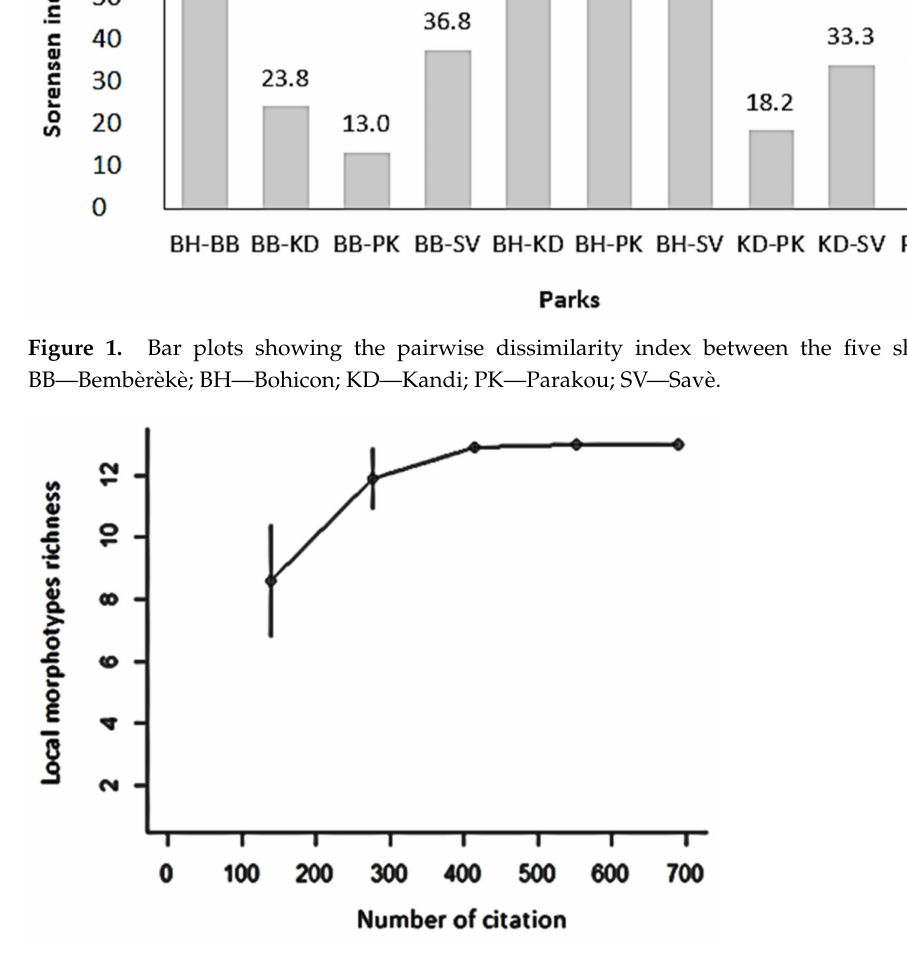
Figure 2. Cumulative curve of morphotype richness in shea based on number of